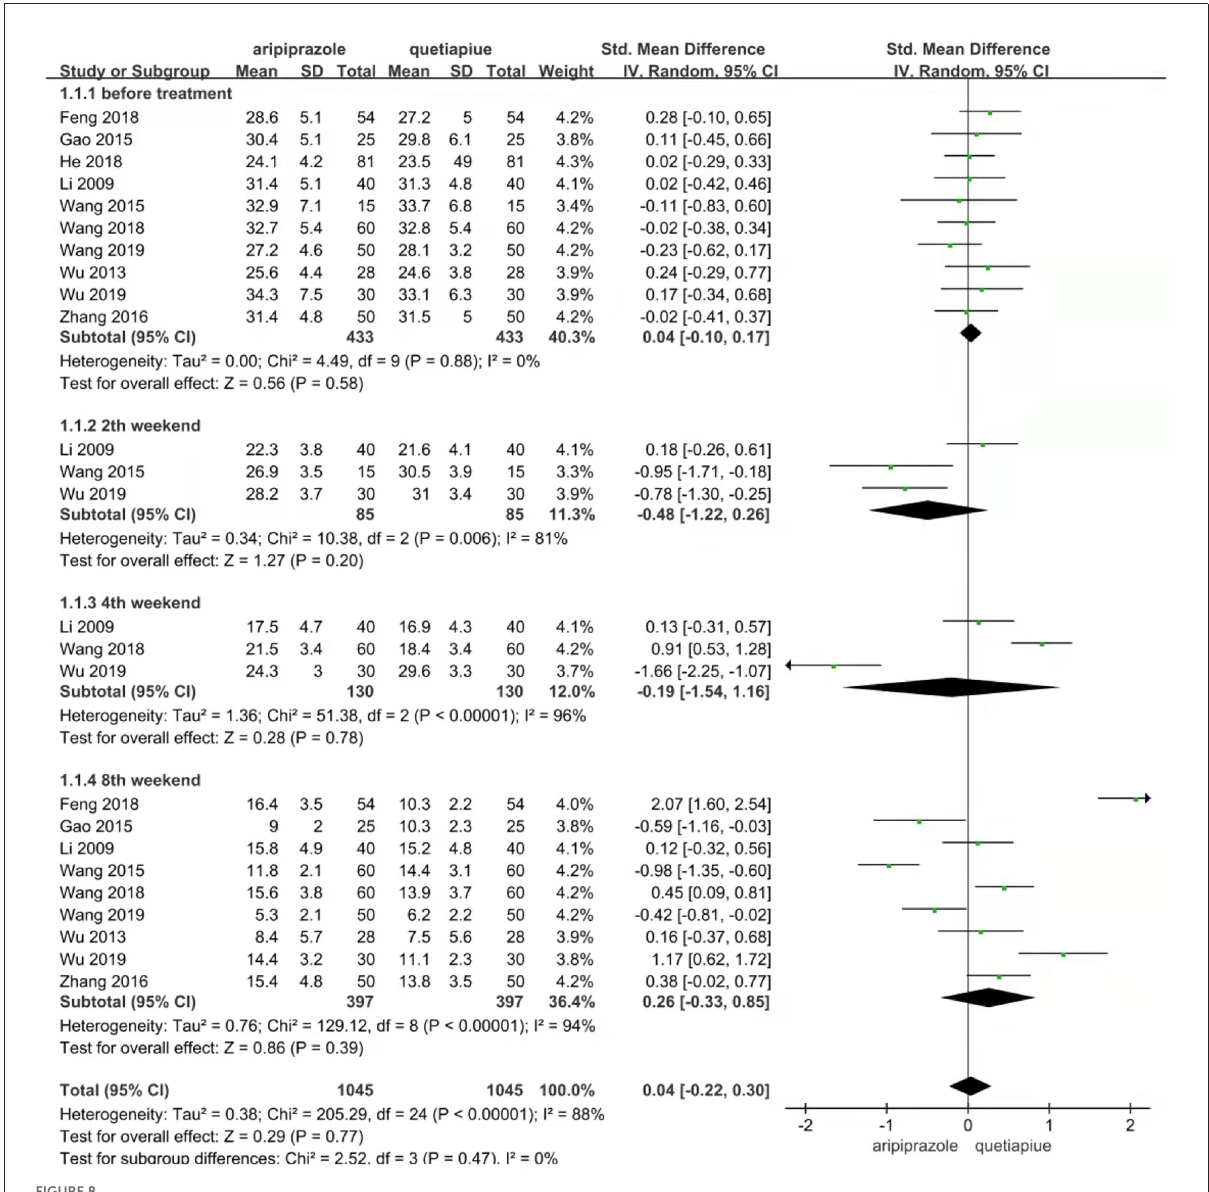
FIGURE8 Comparison of HAMD scale between aripripazole and quetiapine in different therapeutic stage. Comparison of HAMD scale were analyzed between aripripazole and quetiapine by random effect model due to their heterogeneity ( X 2 = 205.29, df = 24, P < 0.00001, I 2 = 88%). Overall there were no difference in HAMD scale between aripripazole and quetiapine before treatment (Z = 0.29, P = 0.77). The HAMD scale of aripiprazole group was silmilar to quetiapine at 2nd weekend (Z = 1.273, P = 0.20). The HAMD scale of aripiprazole was similar to quetiapine at 4th weekend (Z = 0.28, P = 0.78). The HAMD scale of aripiprazole was significantly higher than that of quetiapine at 8th weekend (Z = 0.86, P =